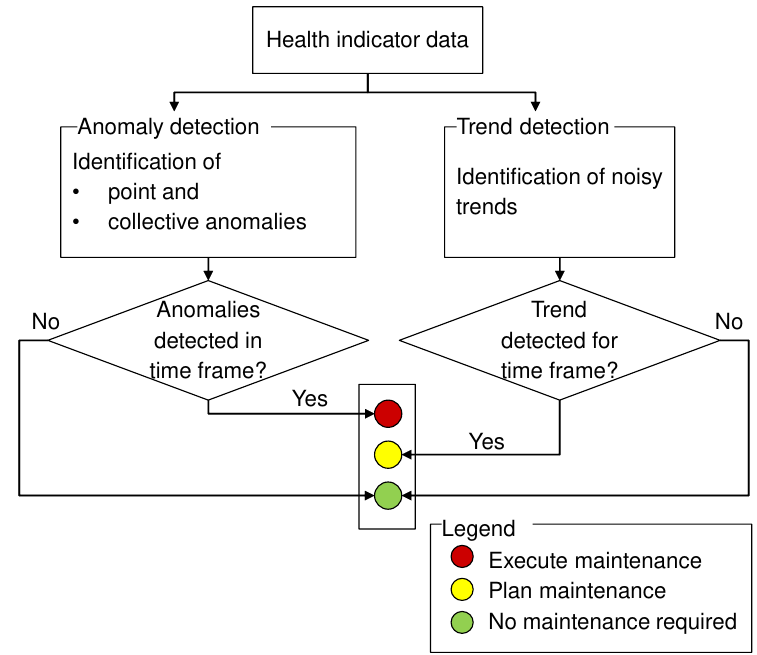
Figure 2. Overview of the condition monitoring system.